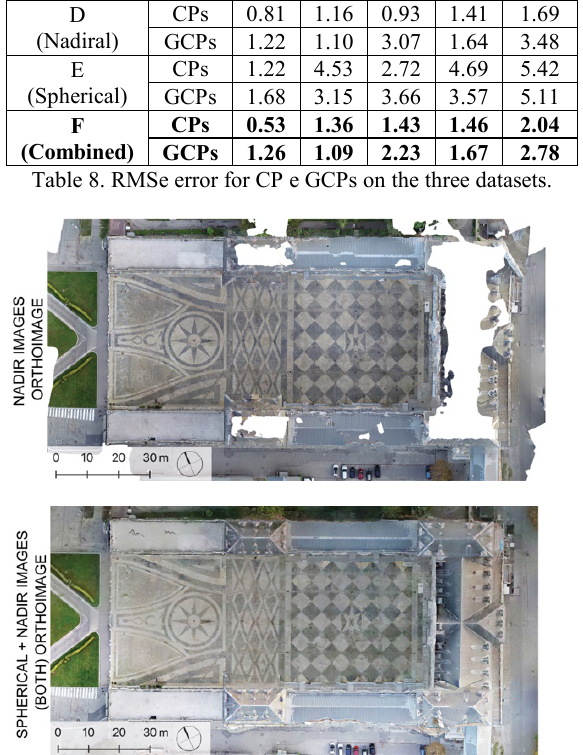
Figure 11. Orthophoto generated from Project D (top) and project F